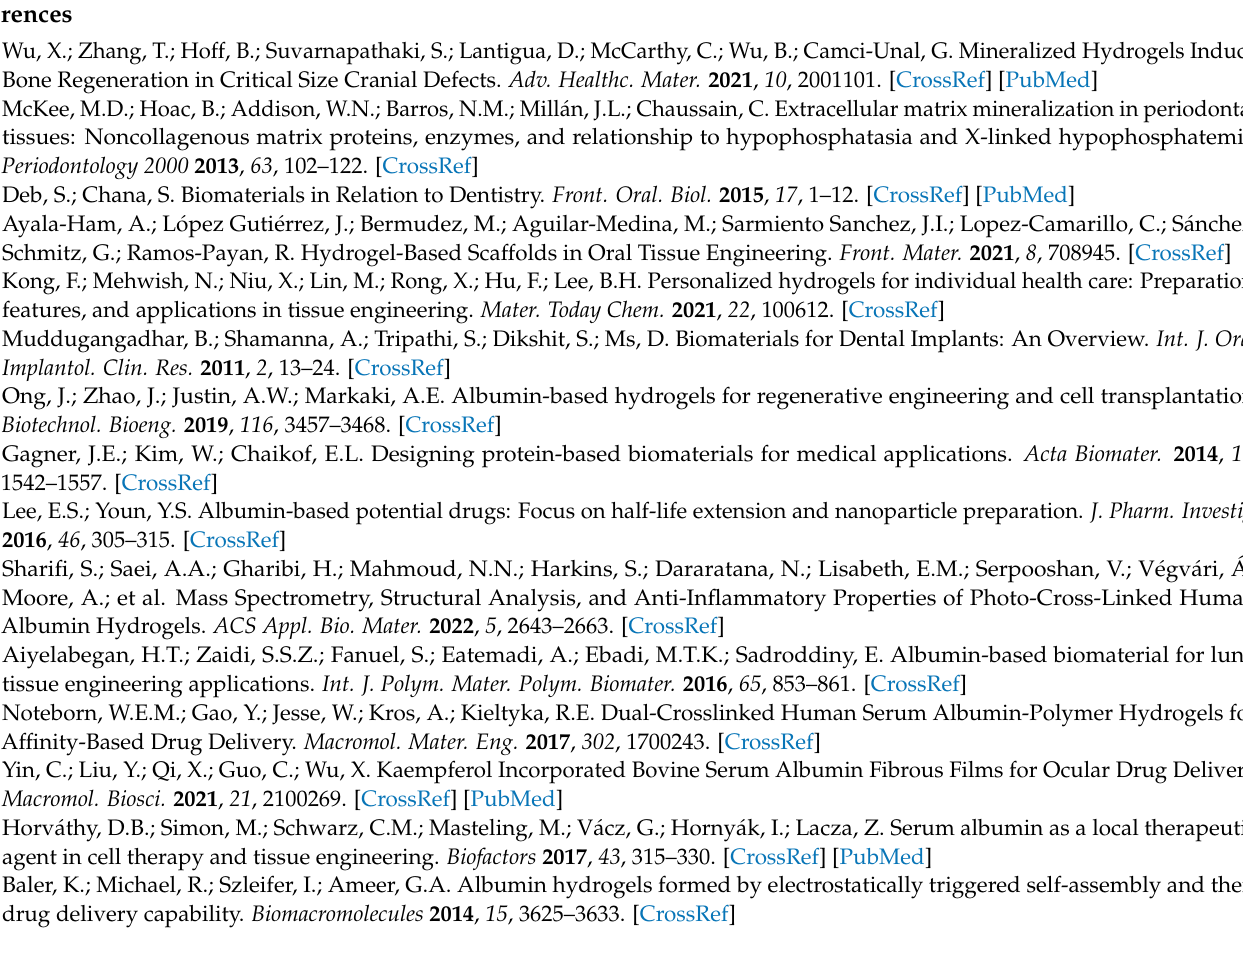
Figure S2: L929 fibroblasts cytocompatibility of BM and BM-PDA cryogels after cultivation for 1,